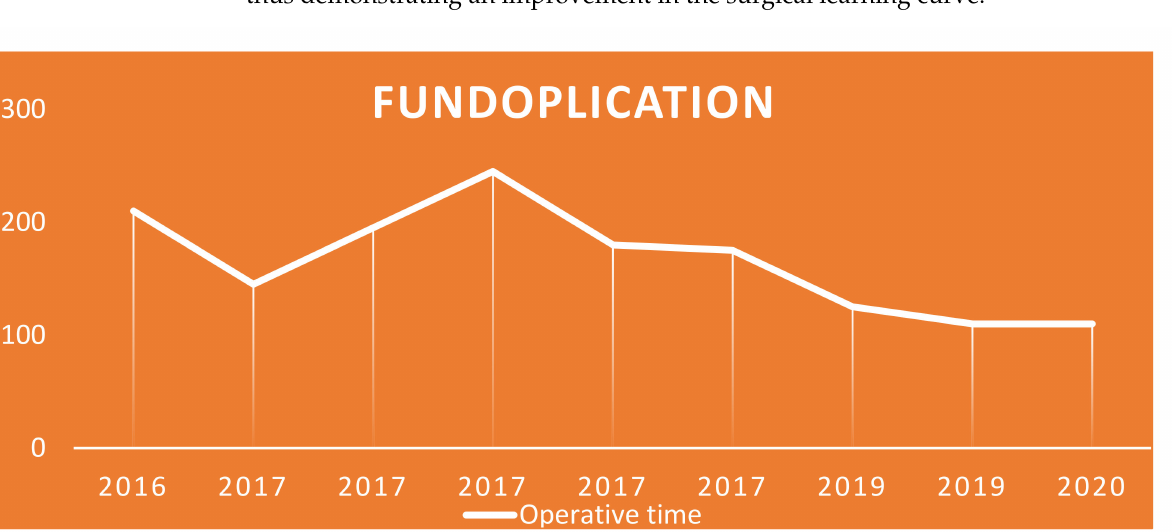
Figure 8. Fundoplication: trend of operating times over the